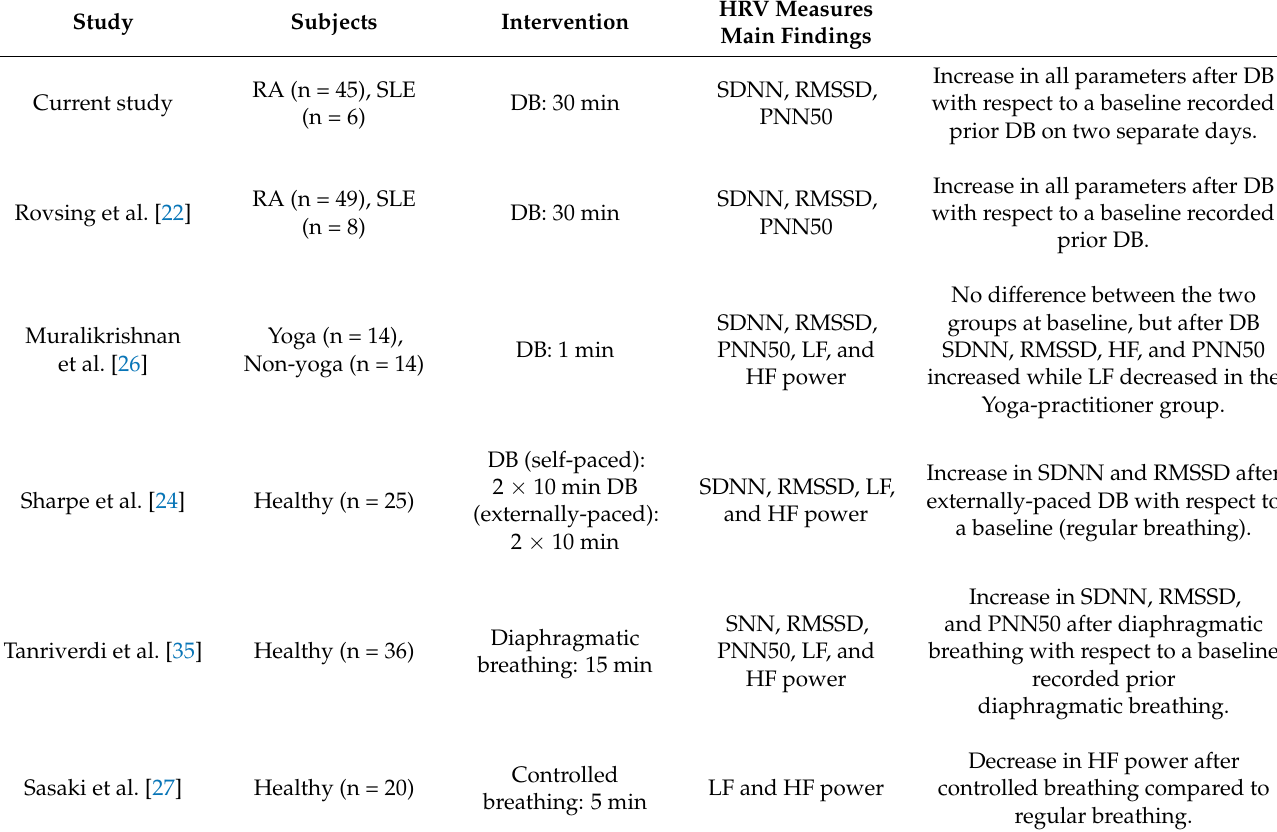
Table 6. Overview of representative deep/controlled breathing